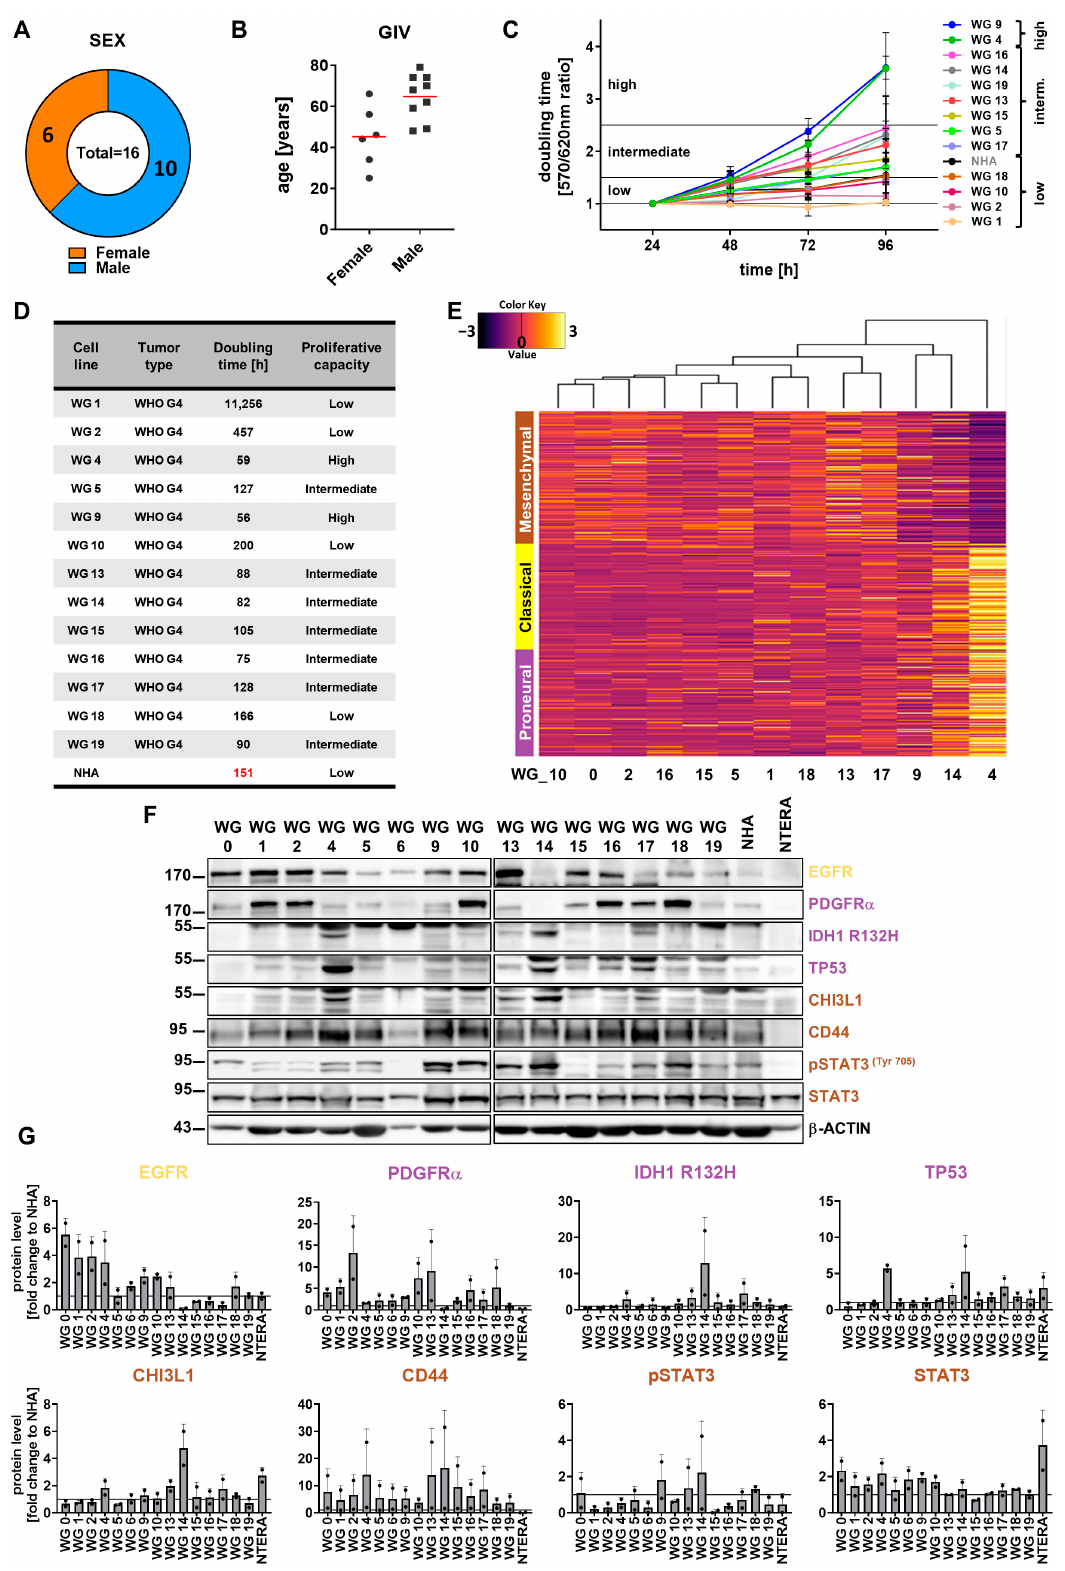
Figure 1. Characterization of glioma patient cohort and transcriptomic and protein-based subtyping of patient-derived primary cell cultures. ( A , B ) Graphical representation of sex ( A ) and age ( B ) of patients in the analyzed glioma cohort . Red line represents the mean age. ( C ) The proliferation capacity of glioblastoma-patient-derived primary cell cultures and normal human astrocytes (NHA) determined by MTT metabolism assay, n = 3, mean ± SD. ( D ) Doubling time of primary glioma cell